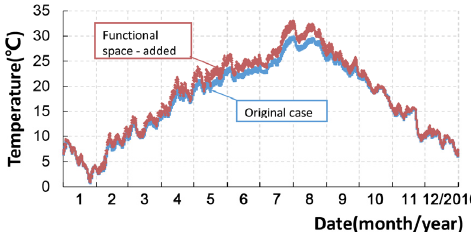
Figure 13. Point 4—temperature change.